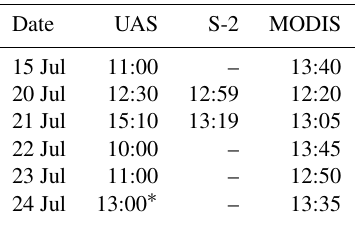
Table A1. Times of data acquisition by UAS, S-2 and MODIS (local time, UTC − 2). Asterisk indicates variable illumination conditions during UAS flight.